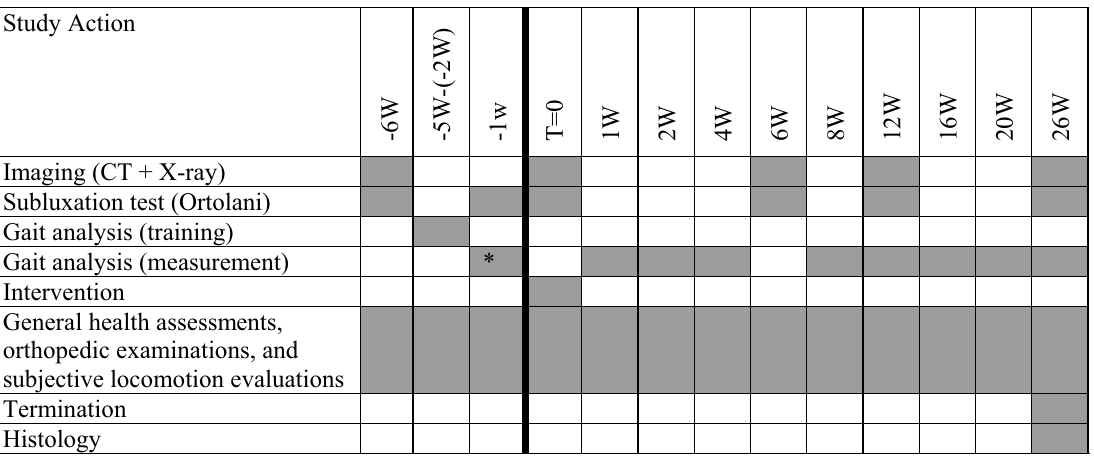
Table 1. Study outline in weeks (W). T = 0 is the time point of intervention. *The preoperative baseline consisted of three measurements conducted on separate days during 1